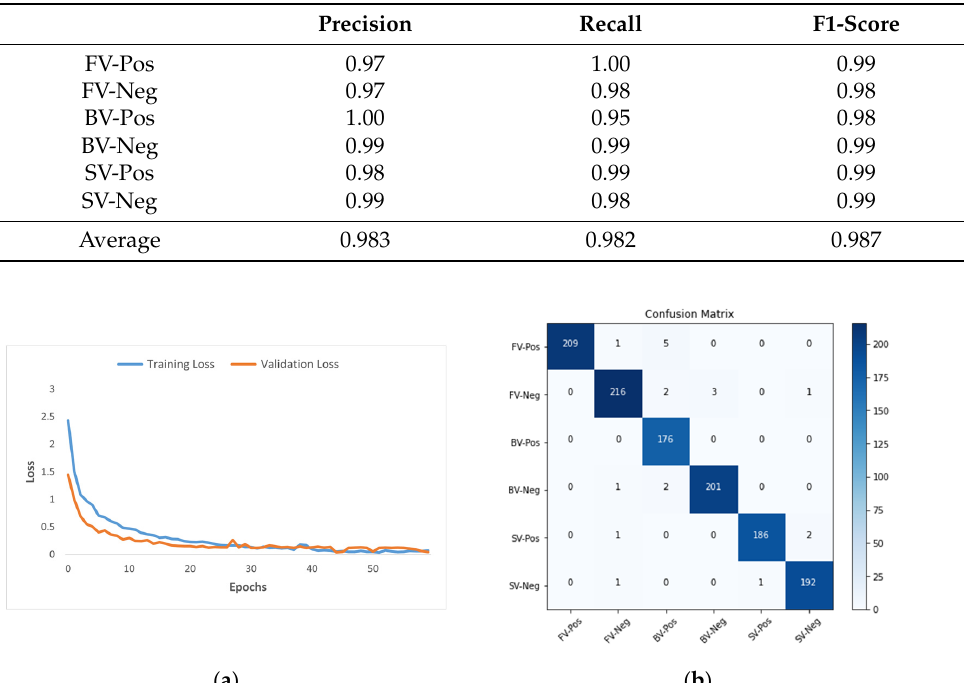
Figure 13. The loss curve and confusion matrix of multi-classification on INRIA, ILIDS, and MSMT17 datasets: ( a ) The loss curve, ( b ) the confusion matrix.